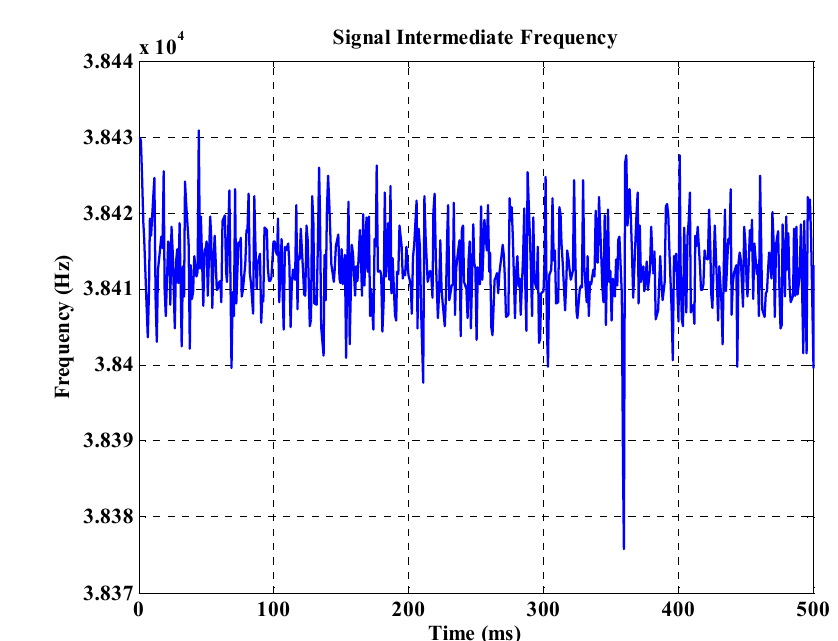
Figure 4 – Change of the frequency of a typical input signal with the frequency disorder that occurs at one point (at 360ms)